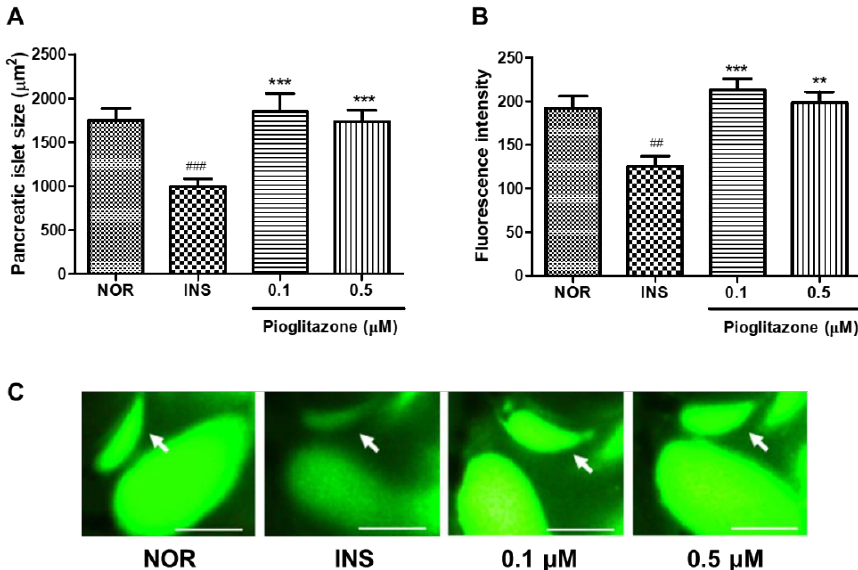
Figure 7. Effects of pioglitazone (PIO) on excess insulin-treated zebrafish. ( A ) Pancreatic islets’ size. (###) p < 0.001; compared to normal group (NOR). (***) p < 0.001; compared to insulin-treated group (INS). ( B ) Fluorescence intensity in the pancreatic islets. (##) p < 0.01; compared to NOR. (**) p < 0.01, (***) p < 0.001; compared to INS. ( C ) Representative pancreatic islet images of the NOR, INS, PIO-treated zebrafish. Pancreatic islets were stained using 2-NBDG. The white arrow indicates the location of pancreatic islet. Scale bar = 100 µ m.